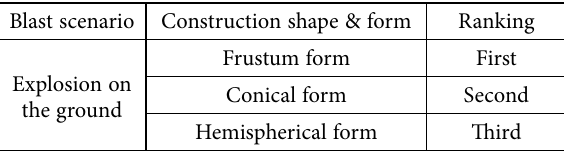
Table 3. Ranking of the building form by the scenario